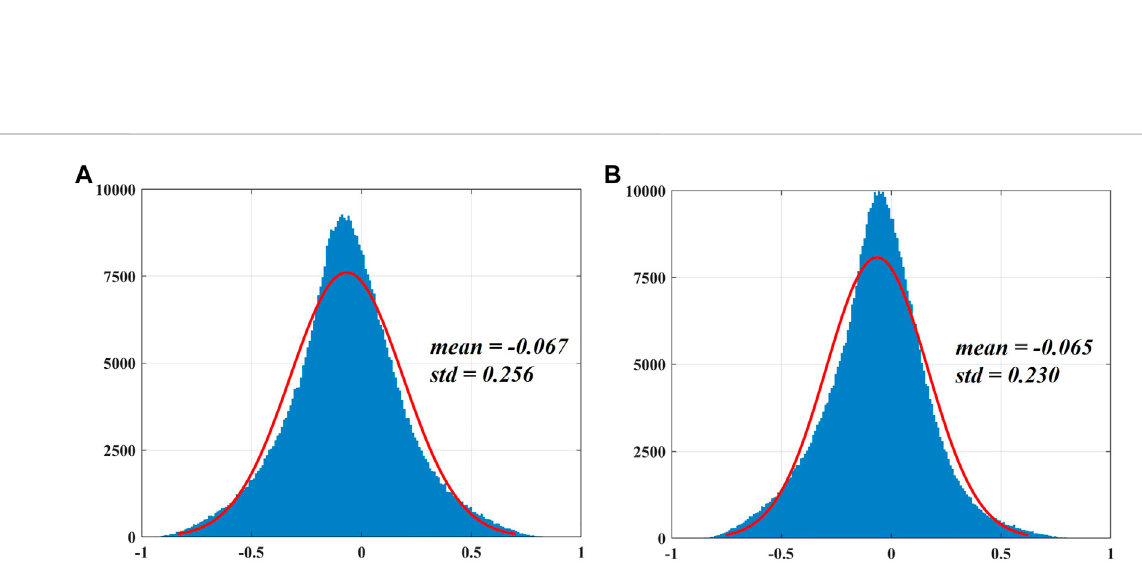
Frontiers in Earth